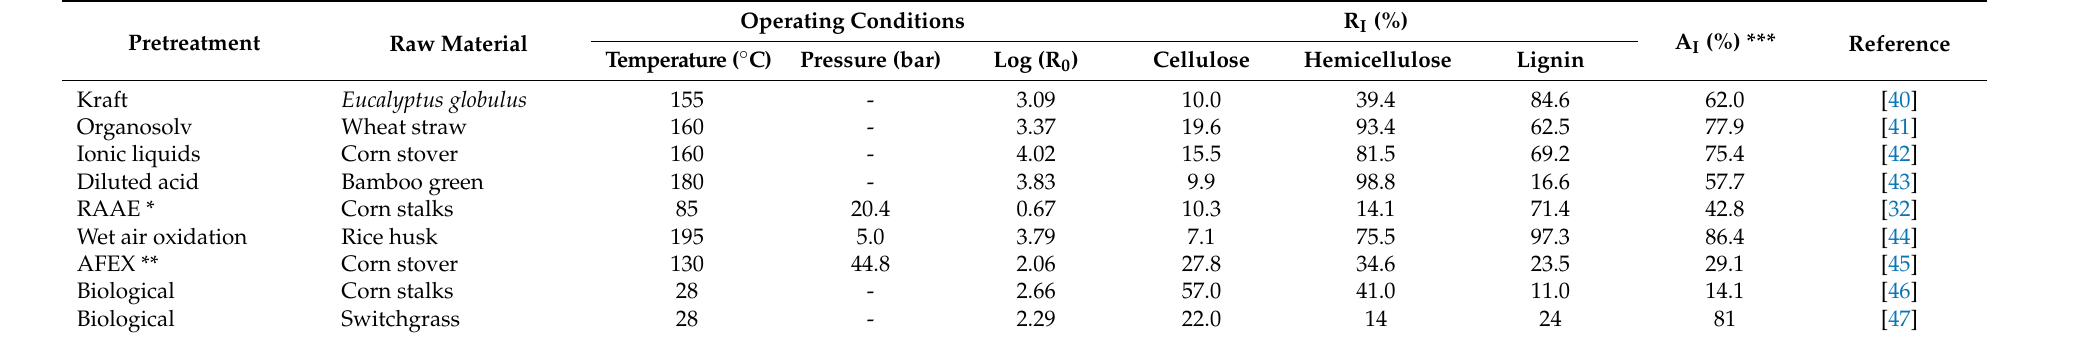
Table 1. Pretreatment screening for cellulose isolation.